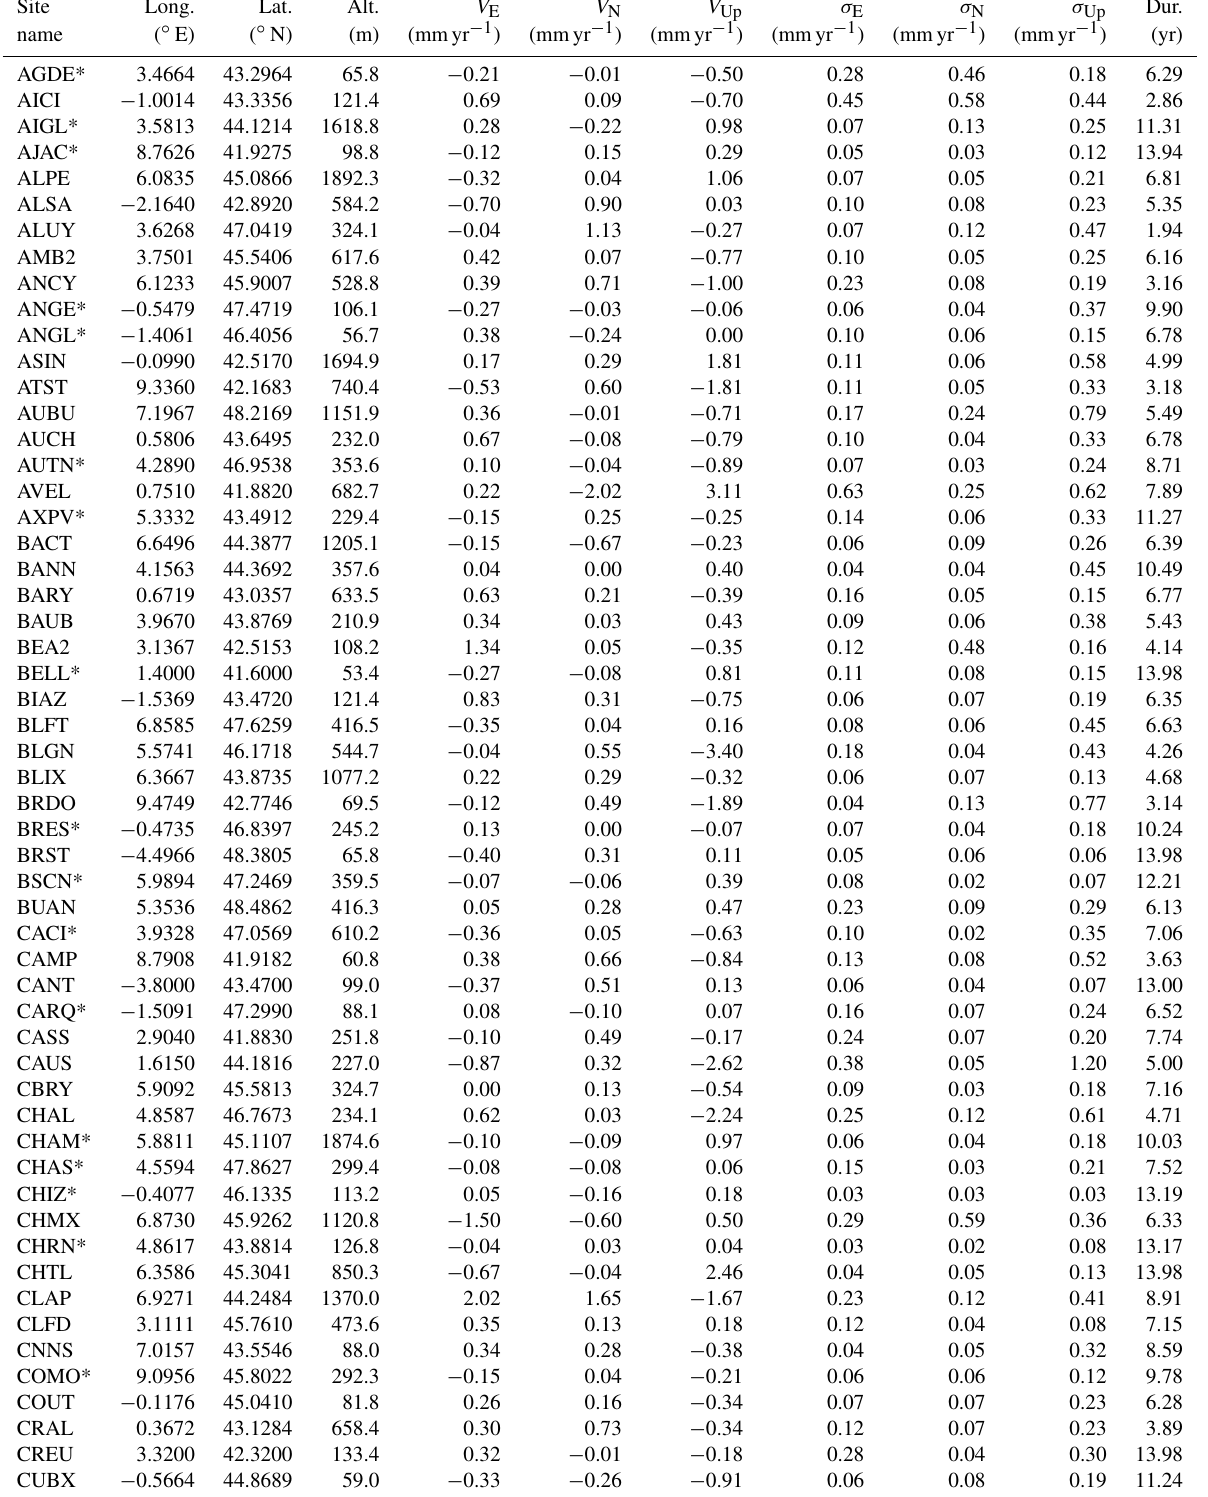
Table 3. Site locations and velocities in a regional (western Europe) reference frame as determined in this study by minimizing the velocities of the 61 sites indicated by an asterisk. East, north, and vertical GPS velocity components ( V E , V N , V Up ) and 1 σ uncertainties ( σ E , σ N , σ Up ) are given inmmyr − 1 . “Dur.” corresponds to the length of the time series. Site Long.